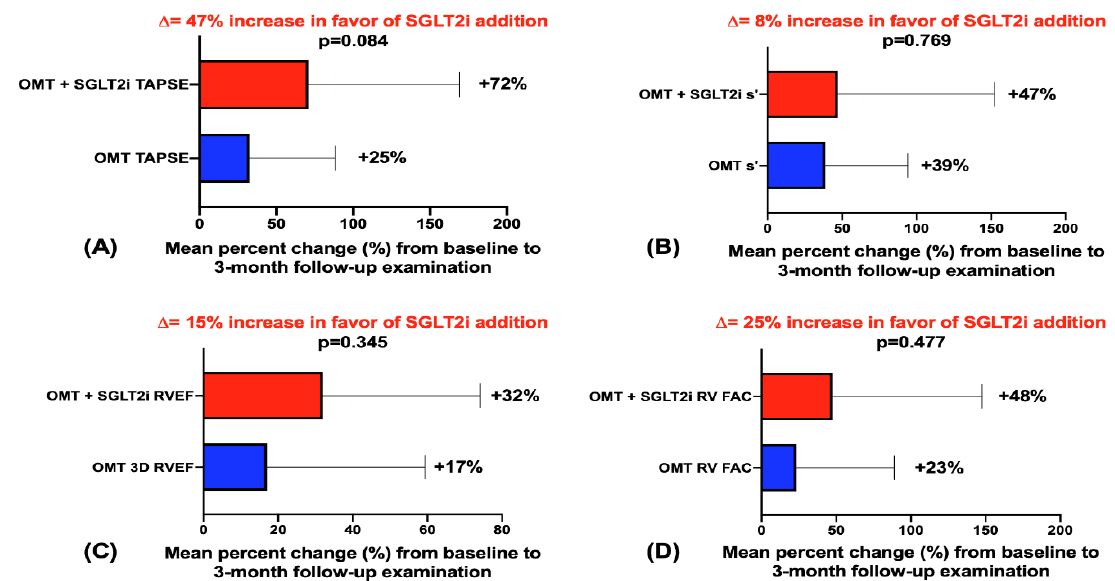
Figure 2. Mean percent change (%) from baseline to 3-month follow-up; red — OMT+SGLT2i group, blue — OMT control group; ( A )—mean percent change in tricuspid annular plane systolic excursion (TAPSE) between groups from baseline to 3mFU; ( B )—mean percent change in Doppler tissue imaging-derived tricuspid lateral annular systolic velocity (s’ wave) between groups from baseline to 3mFU; ( C )—mean percent change in right ventricular ejection fraction measured by three-dimensional echocardiography between groups from baseline to 3mFU; ( D )—mean percent change in fractional area change (FAC) between groups from baseline to 3mFU.